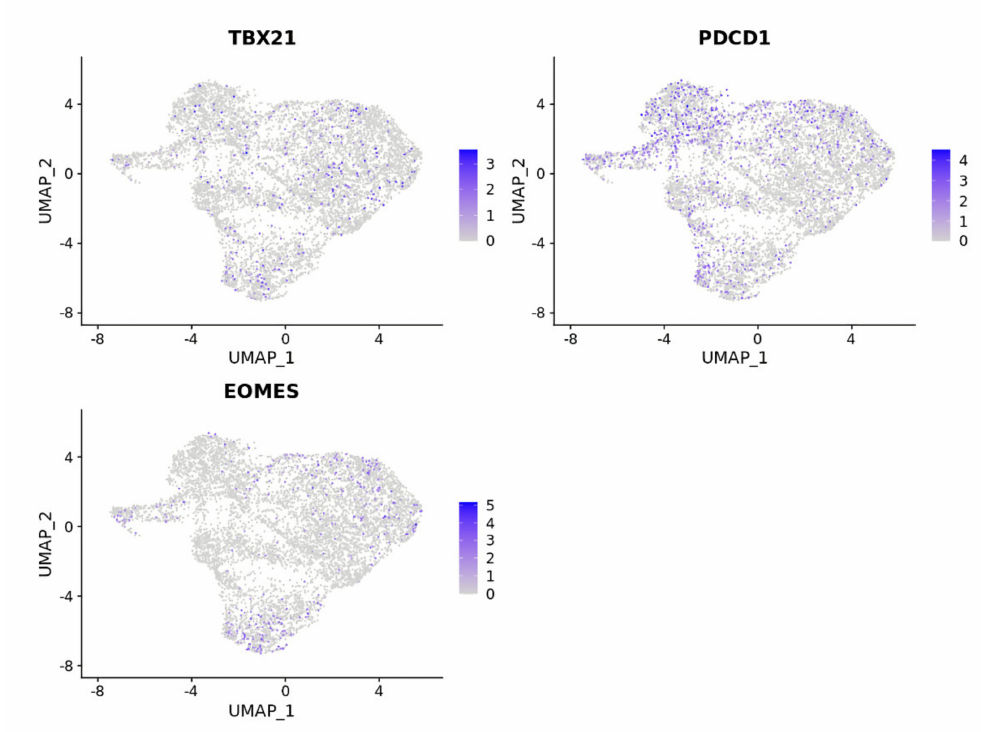
Figure 12. Feature plot to show the distribution of TBX21, PDCD1, and EOMES in each cluster. PDCD1 showed the highest density in CD8+ T EX (clusters 1 and 7) and was associated with CD8+ T EM . The x -axis and y -axis are two dimensions of the